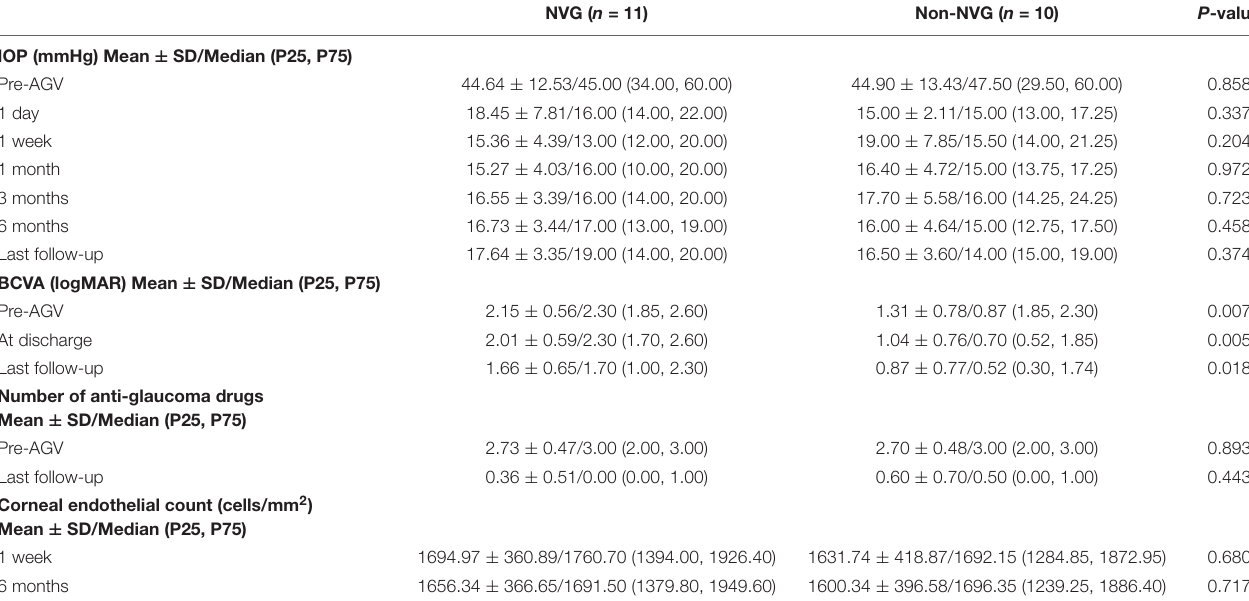
TABLE 3 | Comparison of IOP, BCVA, and number of anti-glaucoma drugs at different time points between NVG and non-NVG patients.